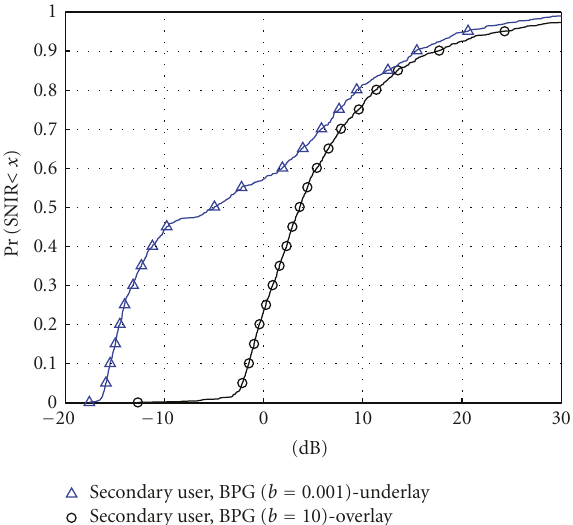
Figure 10: SINR results for SUs considering di ff erent values of b : underlay versus overlay, when the outage probability of PUs is 3%.